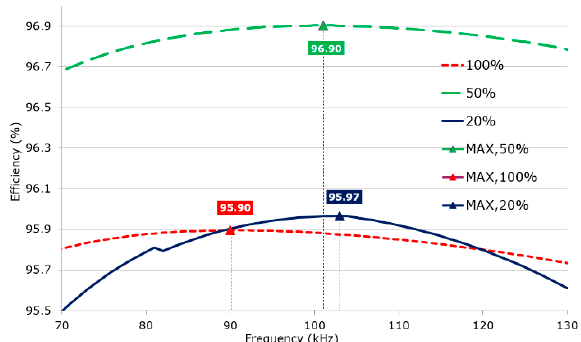
Figure 16. Efficiency plot of the system as a function of the switching frequency. Not including fan. Keeping the wide input design maintaining a minimum freewheeling time (Lr is updated for each frequency in consequence).